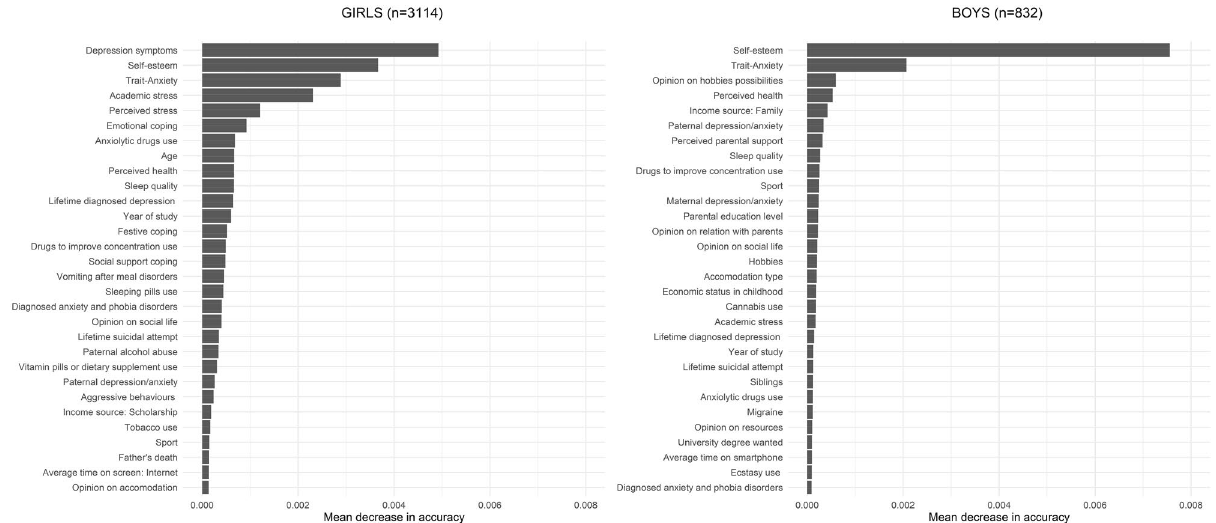
Figure 3. Ranking of the importance of baseline variables in a random forests model for predicting one-year suicidal thoughts and behaviours, removing participants with baseline suicidal thoughts and behaviours, stratified by